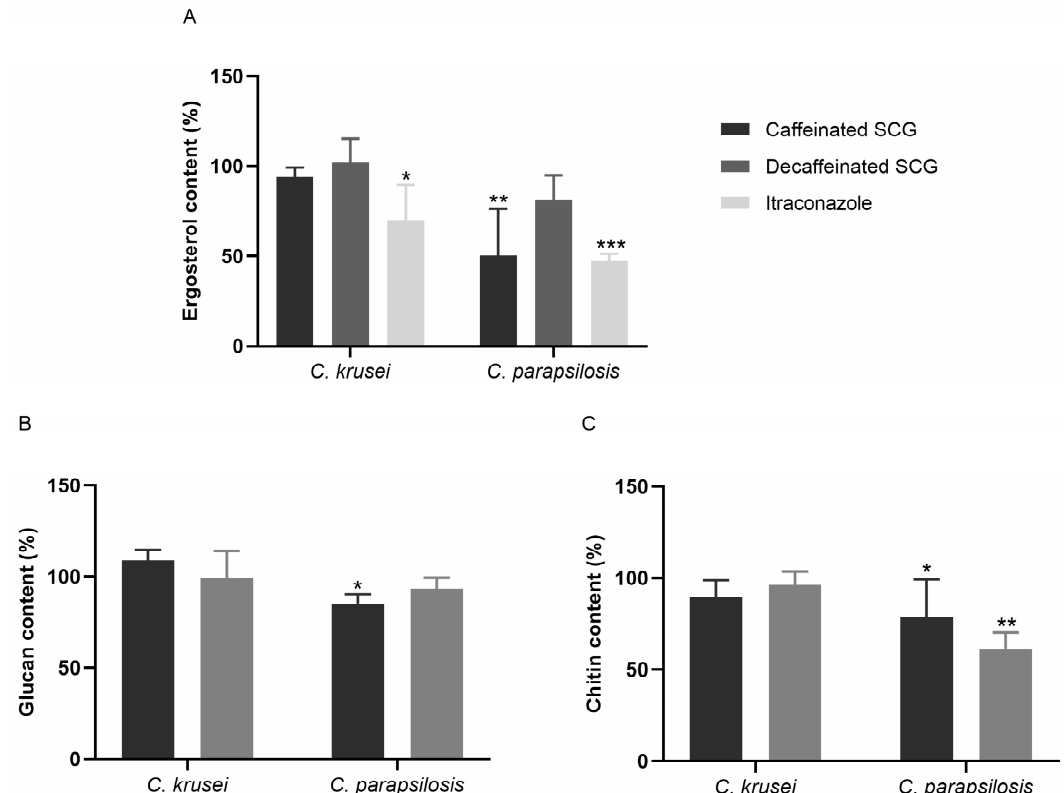
Figure 1. Effects of caffeinated and decaffeinated SCG extracts on cell membrane and cell wall components of yeasts. C. krusei treated with 137.50 µ g/mL of caffeinated SCG extract, 150 µ g/mL of decaffeinated SCG extract, and 0.016 µ g/mL of itraconazole. C. parapsilosis treated with 275 µ g/mL of caffeinated SCG extract, 150 µ g/mL of decaffeinated SCG extract, and 0.016 µ g/mL of itraconazole. ( A ) Ergosterol, ( B ) β -(1,3)-glucan, and ( C ) chitin contents. Results are expressed as mean ± standard error and are a representation of three independent experiments performed in triplicate, * p < 0.05, ** p < 0.01, and *** p < 0.001 (Dunnett’s post-hoc test). Data were normalized to control values. In respect to filamentous fungi, the ergosterol content of T. mentagrophytes after ex- posure to caffeinated and decaffeinated SCG extracts showed no decrease, even when treated with itraconazole (0.016 µ g/mL) (Figure 2A). Treatment with caffeinated SCG extracts reduced the total amount of ergosterol of T. rubrum by 12.05% but the decaffeinated SCG extracts had no impact. Itraconazole lowered the ergosterol content by 26.68%, with no statistical significance. The β -(1,3)-glucan content of T. mentagrophytes and T. rubrum (Figure 2B) had no decrease when exposed to caffeinated SCG extracts. The decaffeinated SCG extract only reduced T. mentagrophytes β -(1,3)-glucan by 18.75% but not with statistical significance. The quantification of chitin content of T. mentagrophytes revealed no significant alterations after treatment with caffeinated and decaffeinated SCG extracts (Figure 2C). The chitin levels of T. rubrum decreased by 12.16% after exposure to the caffeinated SCG ex- tract, without statistical significance. Curiously, exposure to the decaffeinated SCG extract increased the total amount of chitin by 25.69% ( p <